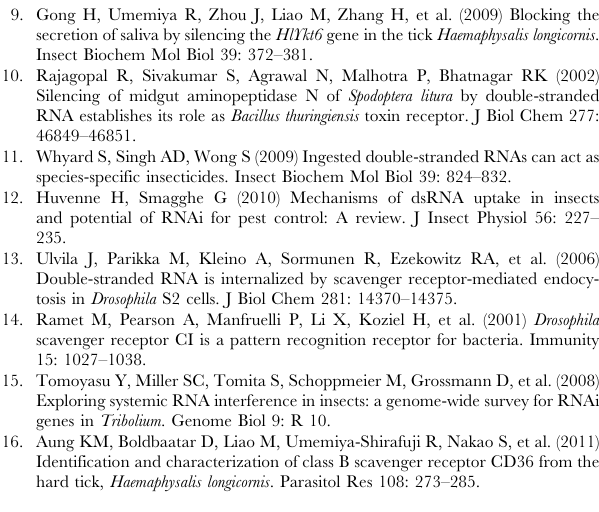
Number of ticks attached 24 h after infestation